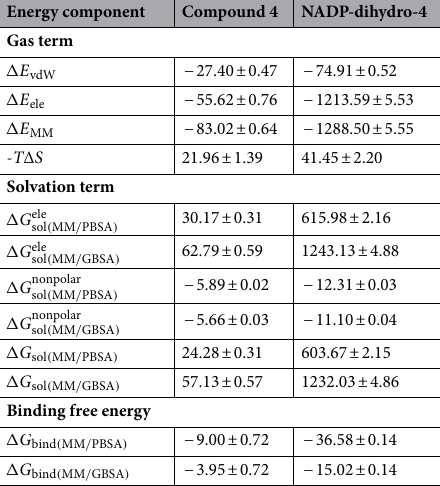
Table 3. Binding free energy and energy components (kcal/mol) of compound 4 (Runs 1 and 2) and NADP- dihydro- 4 (Run 1) in complex with SRD5A1 calculated with MM/(PB)GBSA method from the last 100-ns MD simulations. Data are shown as means ± the standard error of the mean